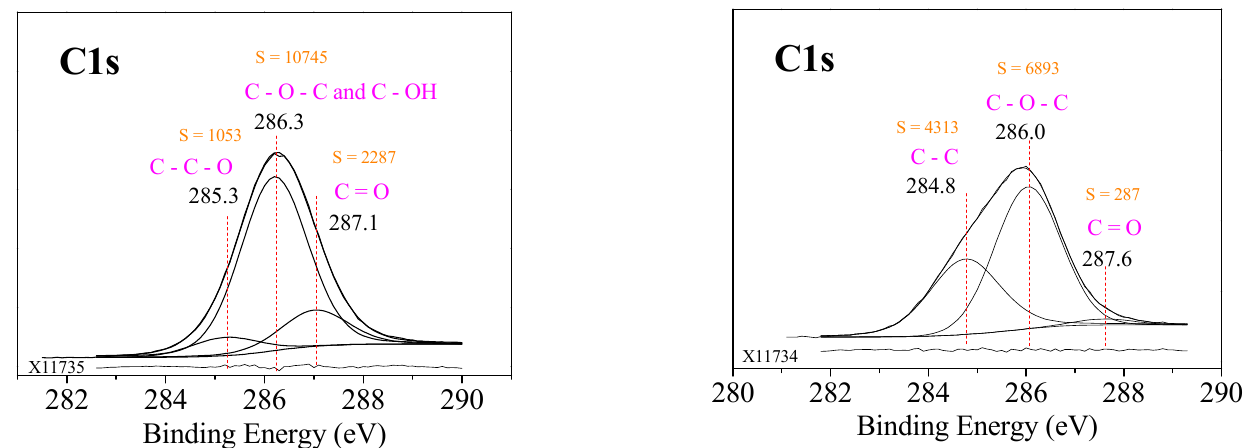
Figure 9. Chemical-state analysis of carbon (C1s) from the XPS spectra of PM 1 , derived from sunflower husk gasification in O 2 /N 2 /CO 2 .